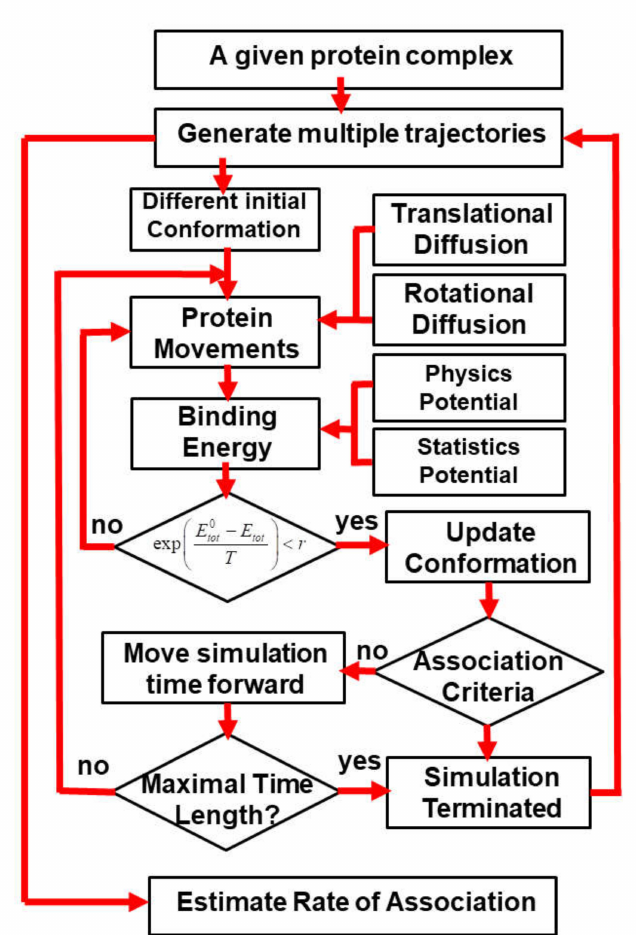
Figure 1. In the kinetic Monte Carlo algorithm, both binding partners in a protein complex undergo random translational and rotational di ff usions after an initial random conformation. Di ff usions are guided by the intermolecular interactions, which are described by a combination of physics-based force fields and statistically derived potentials. The probability of accepting a new configuration after di ff usions is calculated by comparing its energy with the old configuration. If the new configuration is accepted, we further check whether an encounter complex can be formed based on a predefined association criterion. If an encounter complex is formed, the current simulation trajectory will be terminated; otherwise, the simulation continues until it reaches the maximal time duration. Rate of association can be finally estimated by generating a large number of simulation trajectories with this